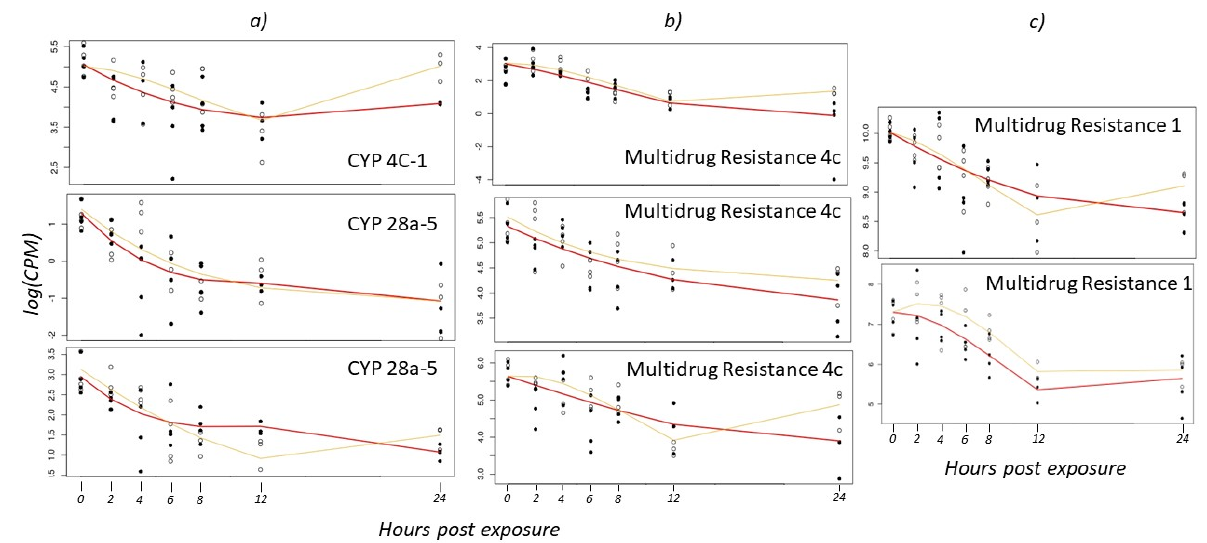
Figure 4. Gene expression in the boll weevil across 24 h following exposure to low and high concentrations of malathion for ( a ) three cytochrome P450 (CYP450) genes, ( b ) three multidrug resistance 4c genes, and ( c ) two multidrug resistance 1 genes (log transformed counts per million). The yellow line indicates the transcriptomic response to the low concentration treatment and the red line indicates the high concentration treatment. Closed circles represent gene expression values for individual weevils exposed to the high concentration of malathion, and open circles are weevils exposed to the low concentration.